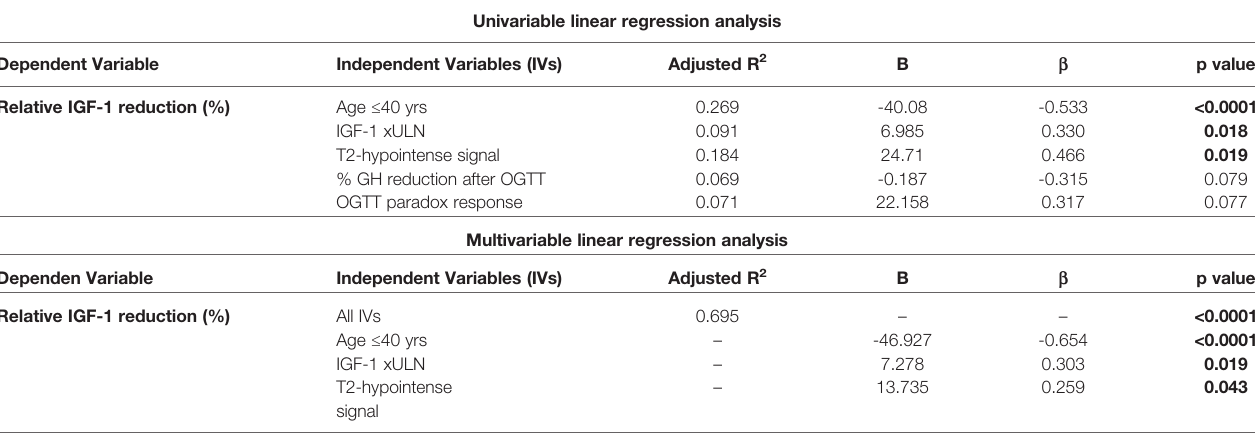
TABLE 3 | Univariable and multivariable linear regression analysis for the predictors of relative IGF-1 reduction (percent reduction after 6-month SRL treatment). Univariable linear regression